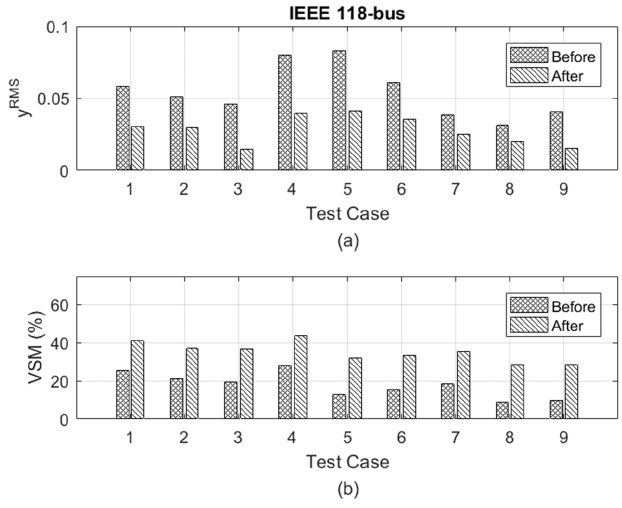
Figure 10. Results of IEEE 118-bus. ( a ) Results in terms of y RMS ; ( b ) Results in terms of VSM .